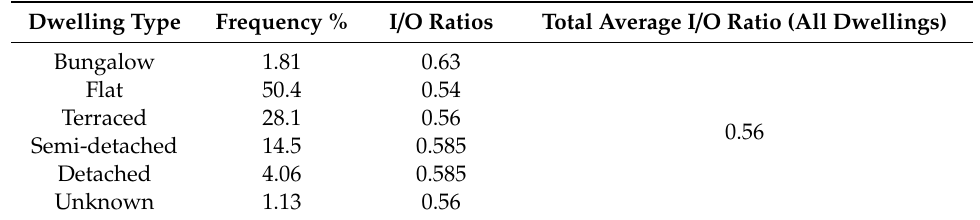
Table 2. London’s dwelling group type descriptions, frequency in stock and average Indoor / Outdoor (I / O)